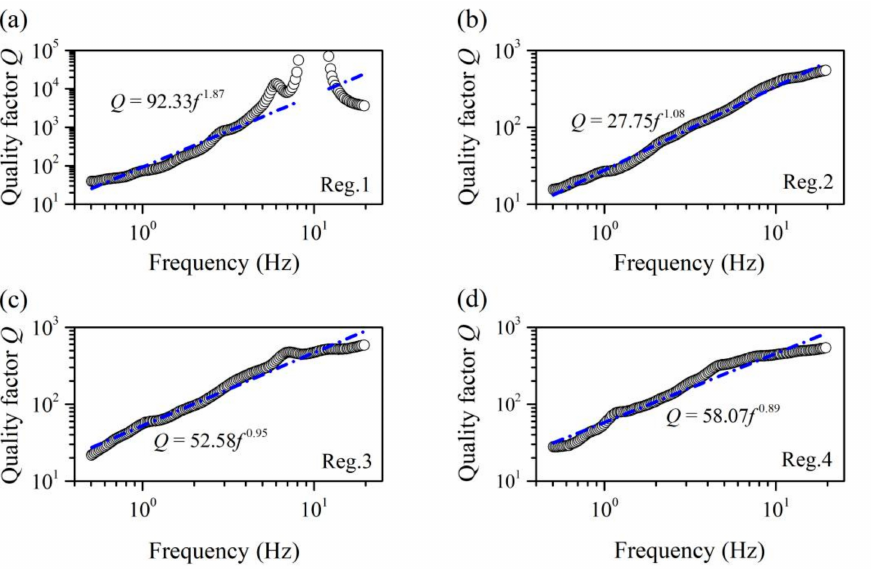
Figure 9. Frequency–dependent S–wave quality factor Q and fitting curves of ( a ) Reg.1, ( b ) Reg.2, ( c ) Reg.3, and ( d ) Reg.4. The solid line represents the least squares regression at frequencies of 0.5–20.0 Hz. The comparison of Q value fitting curves of the four regions is shown in Figure 10.